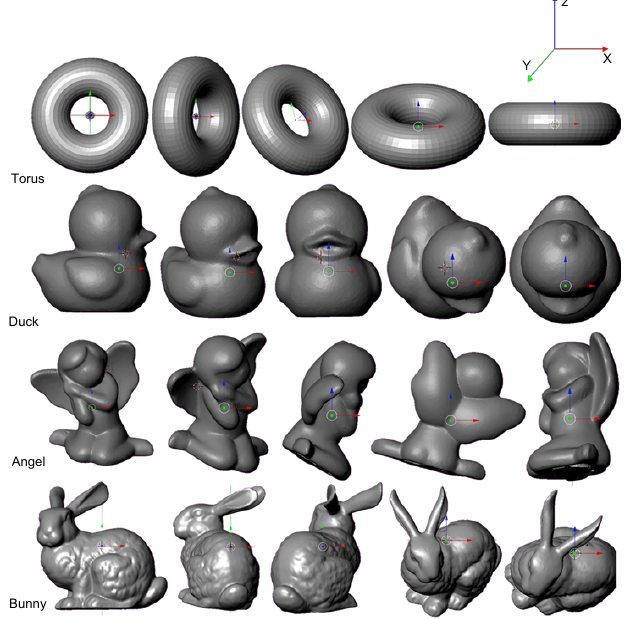
Fig. 11. The 5 poses used in the quantitative evaluation of each object. Each pose was tried 100 times with different noise